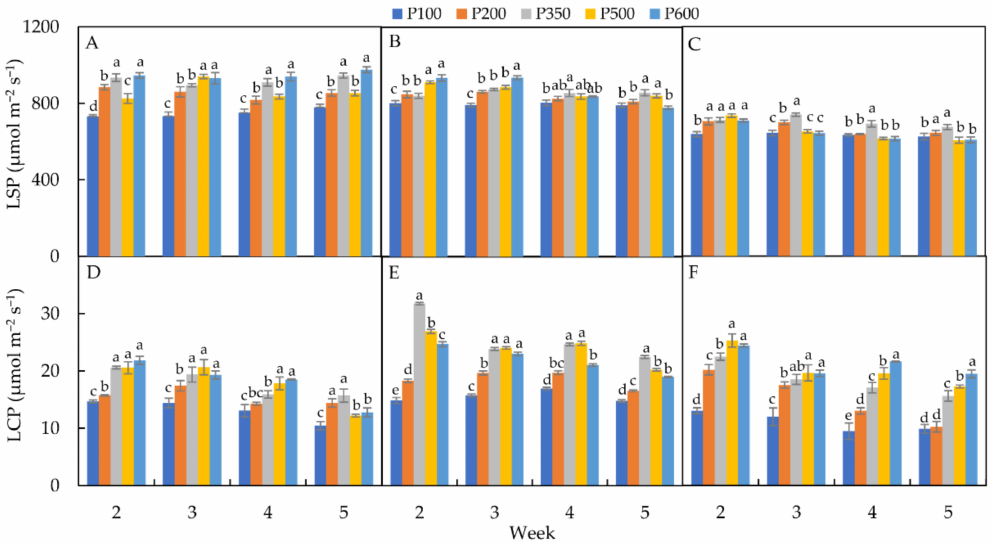
Figure 3. Light-saturation point (LSP) ( A – C ) and light-compensation point (LCP) ( D – F ) under different temperature and light conditions. Mean values with standard error of mean ( n = 3). Left side ( A , D ), middle ( B , E ), and right side ( C , F ) represented T15, T23, and T30, respectively. Letters indicate significant differences at p < 0.05 according to the LSD